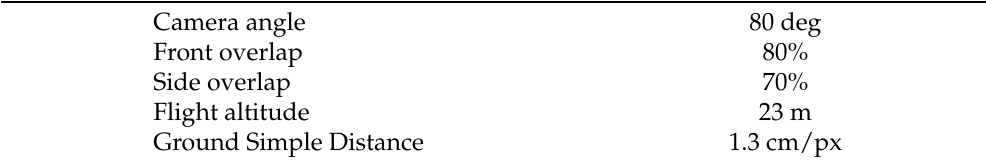
Figure 1. An example of roof tiles characterized by different shape, dimensions, colors and integrity. Table 2. Adopted configuration for the 20